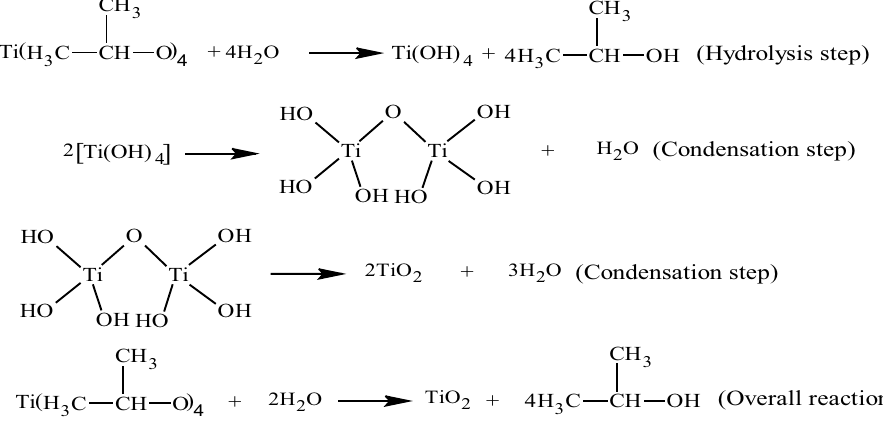
Fig. 4 Hydrolysis and conden- sation reactions of titanium iso- propoxide for TiO 2